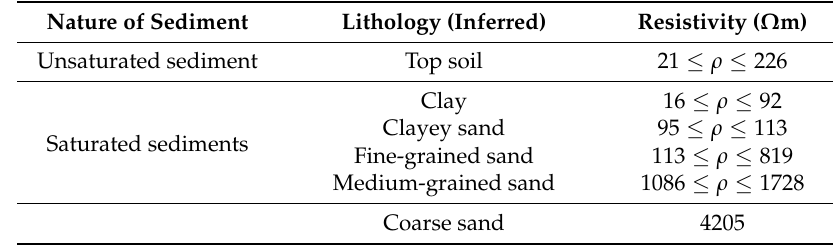
Figure 5. Geoelectric section showing the VES point along the direction west–east. Table 1. Geoelectrical model of the study area.